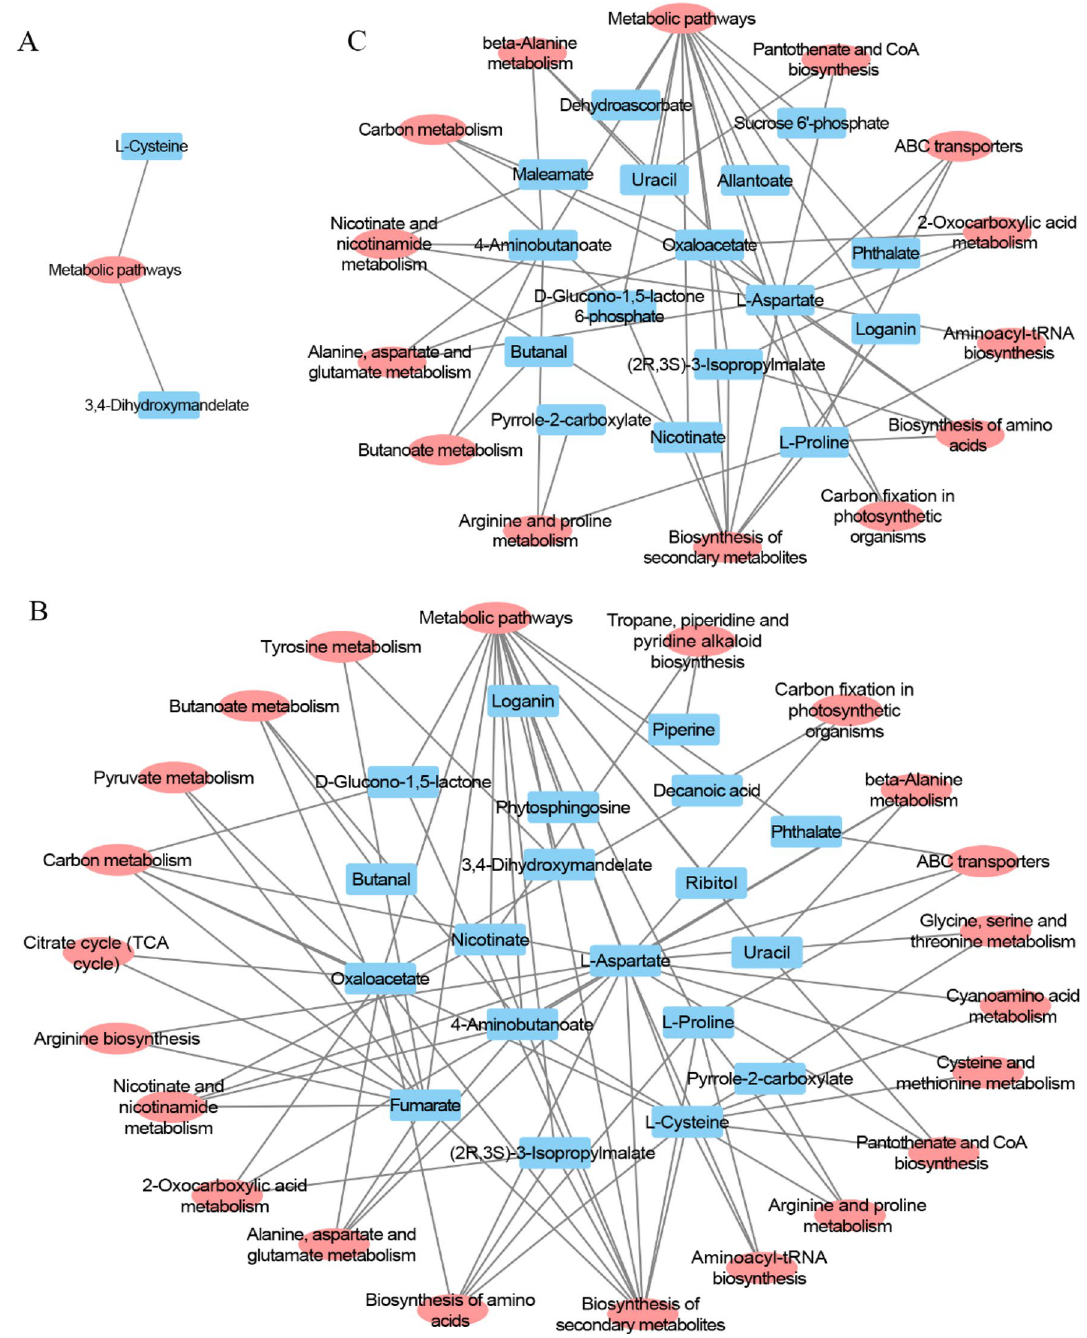
Figure 7. Metabolic pathways of differentially expressed metabolite mapped in N. sibirica leaves under different NaCl concentration treatment. Blue box shows the differentially expressed metabolite between different treatments, red oval shows the metabolic pathway of differentially expressed metabolite mapped. ( A ) T100L vs T0L; ( B ) T400L vs T0L; ( C ) T400L vs